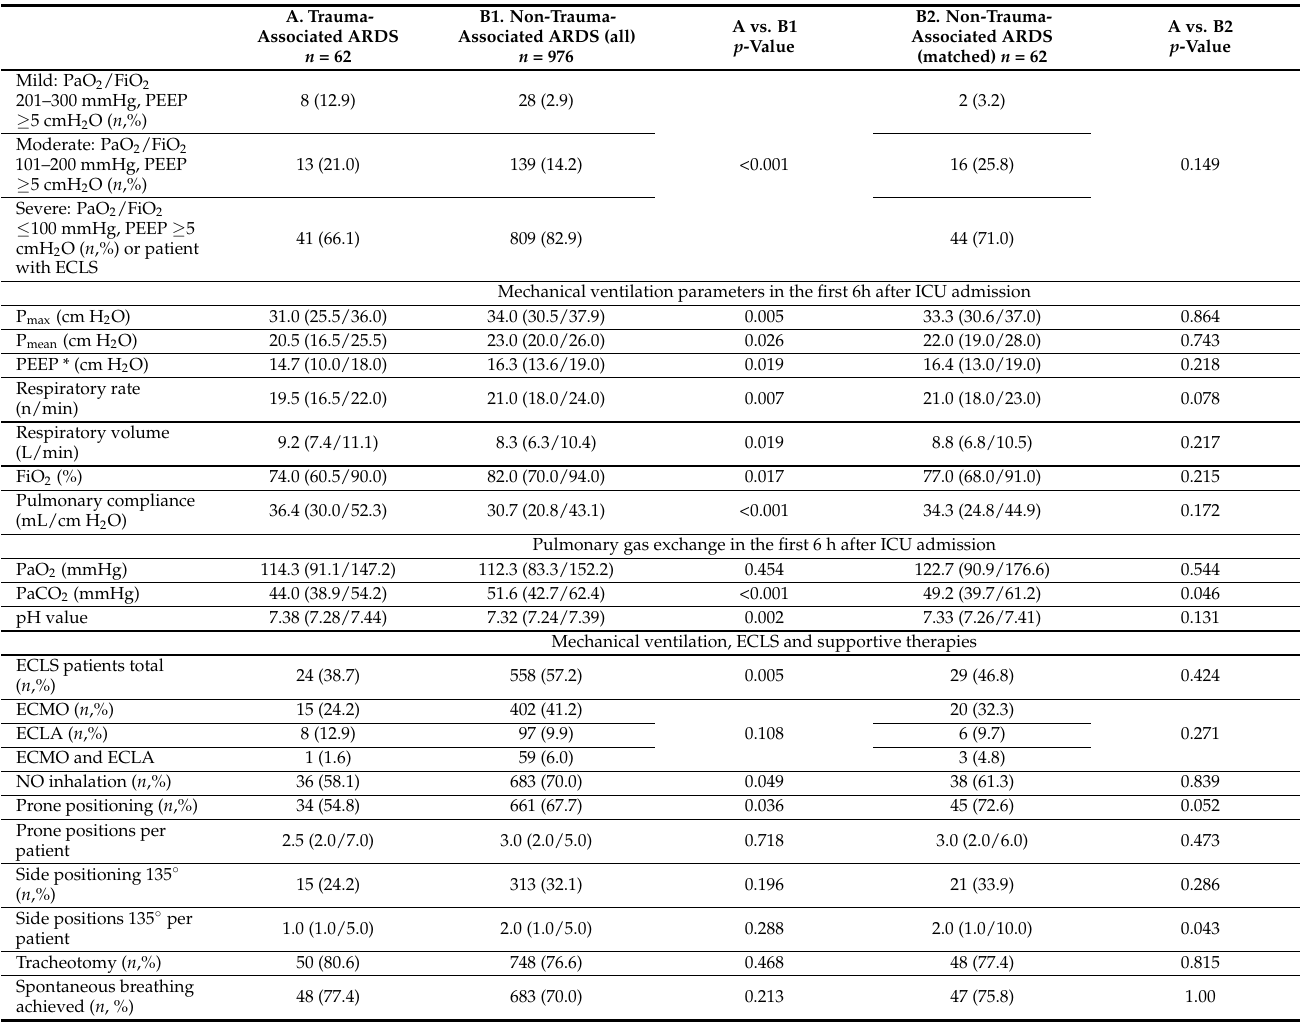
Table 3. Severity of ARDS, gas exchange, mechanical ventilation settings, and supportive